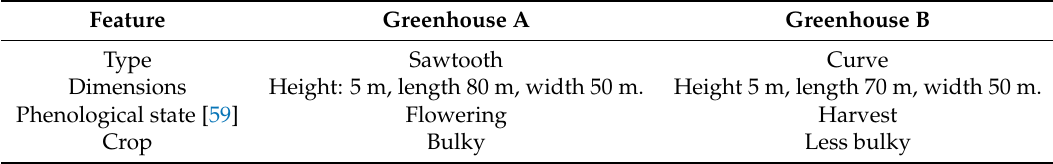
Table 5. Characteristics of tomato